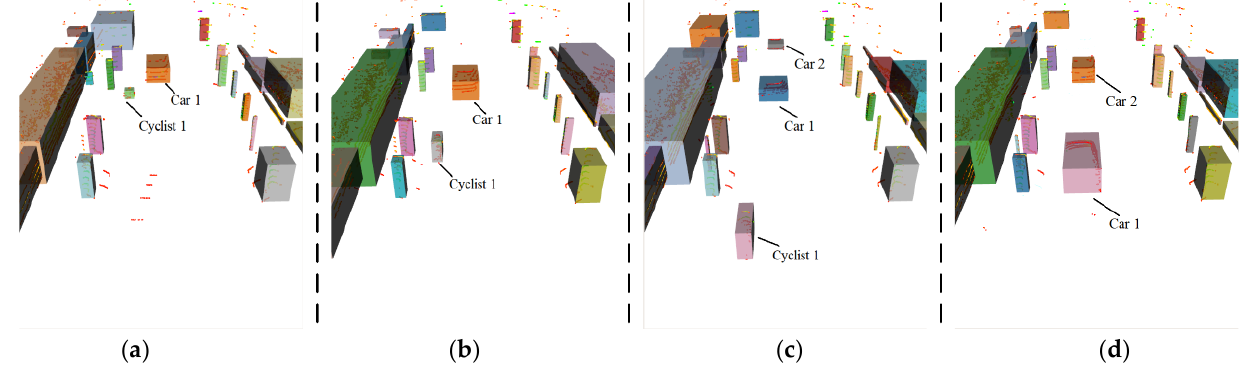
Figure 17. Continuous detection of proposed method: ( a ) 2.5 s; ( b ) 5.0 s; ( c ) 7.5 s; ( d ) 10.0 s.